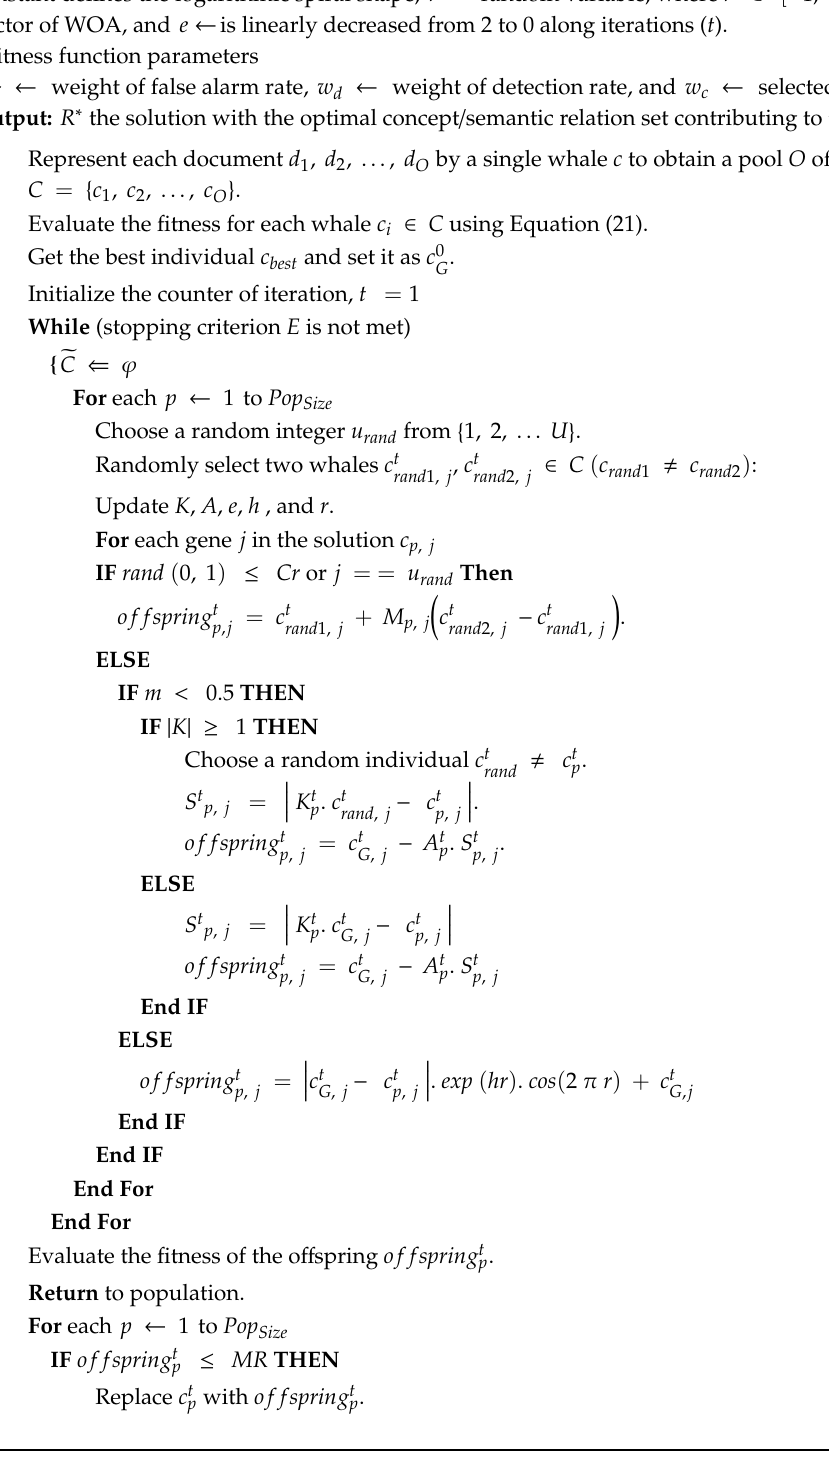
Algorithm 2: The proposed hybrid G-WOA Algorithm for ontology learning from Arabic text Input: A vector R assigns the document’s mapped features. // The G-WOA algorithm